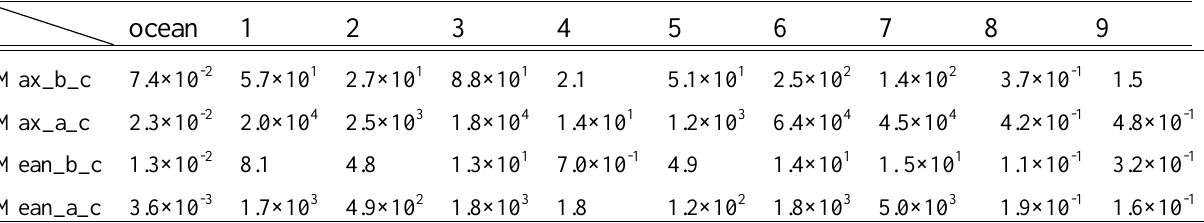
Table 1. The max power and mean power before and after convolution. The parameters Max_b_c,and Max_a_c represent the maximum of power before and after convolution, respectively. In a similar way, Mean_b_c and Mean_a_c can be referred as the mean power at two